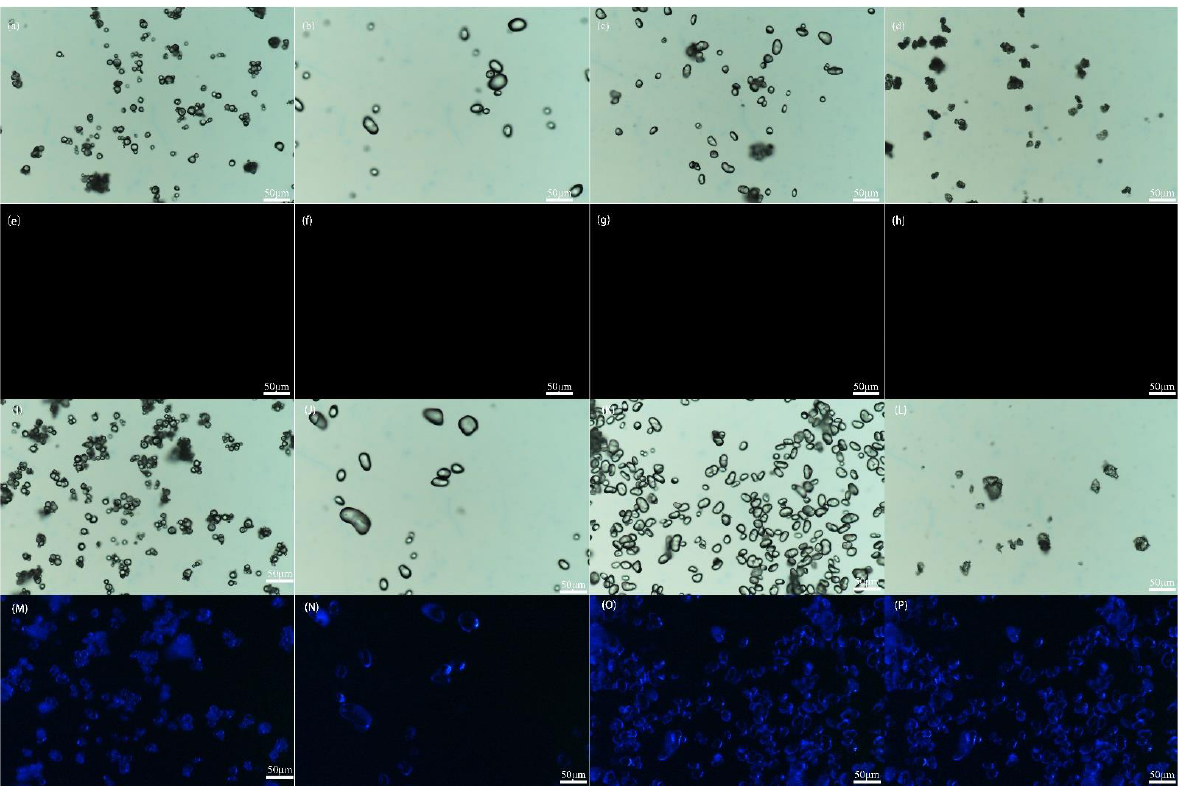
Figure 2. Fluorescence micrographs of four inclusions and four crystal types of starches. ( a – h ) represent the four unmodified starches, where ( a – d ) are taken in the bright field and ( e – h ) are taken in the dark field. A–, B–, C–, and V–type are illustrated from left to right. ( I – P ) represent the four inclusions, where I–L are taken in the bright field and M–P are taken in the dark field. A–SA, B–SA, C–SA, and V–SA are illustrated from left to right.